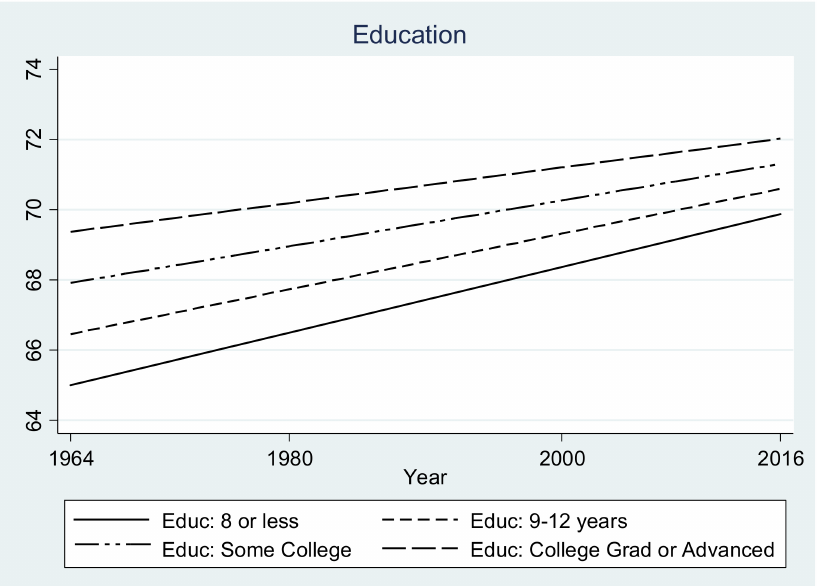
Figure 4. Impact of education on the Jewish feeling thermometer, 1964–2016. Based on results from Table 3. Source: American National Election Studies,